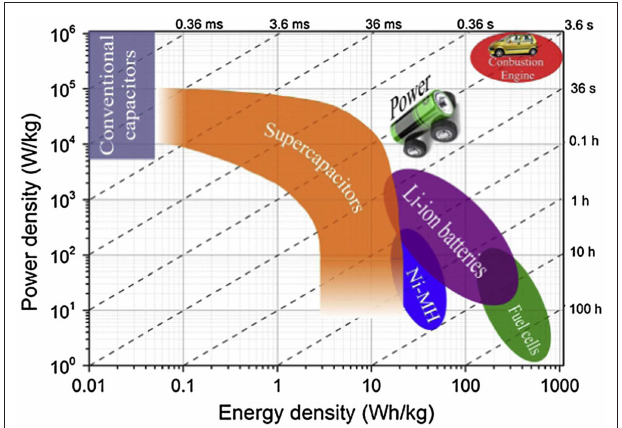
FIGURE 1 | Ragone plots of various electrochemical energy storage (EES) systems. Reproduced from (Wang J. G. et al., 2015), with permission from